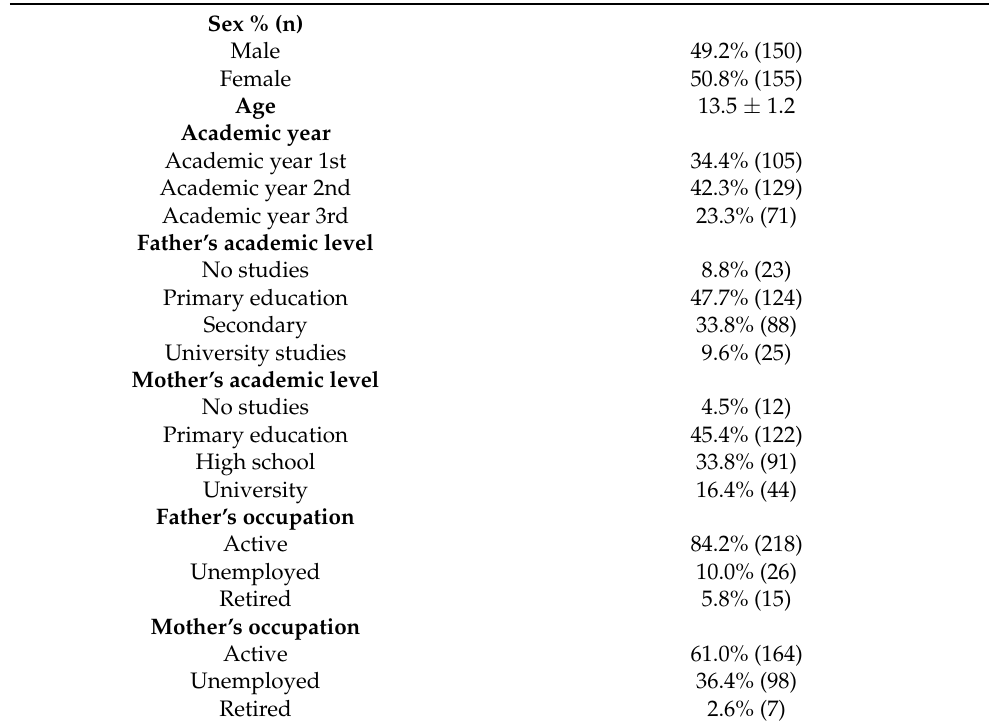
Table 1. General characteristics of the participants.